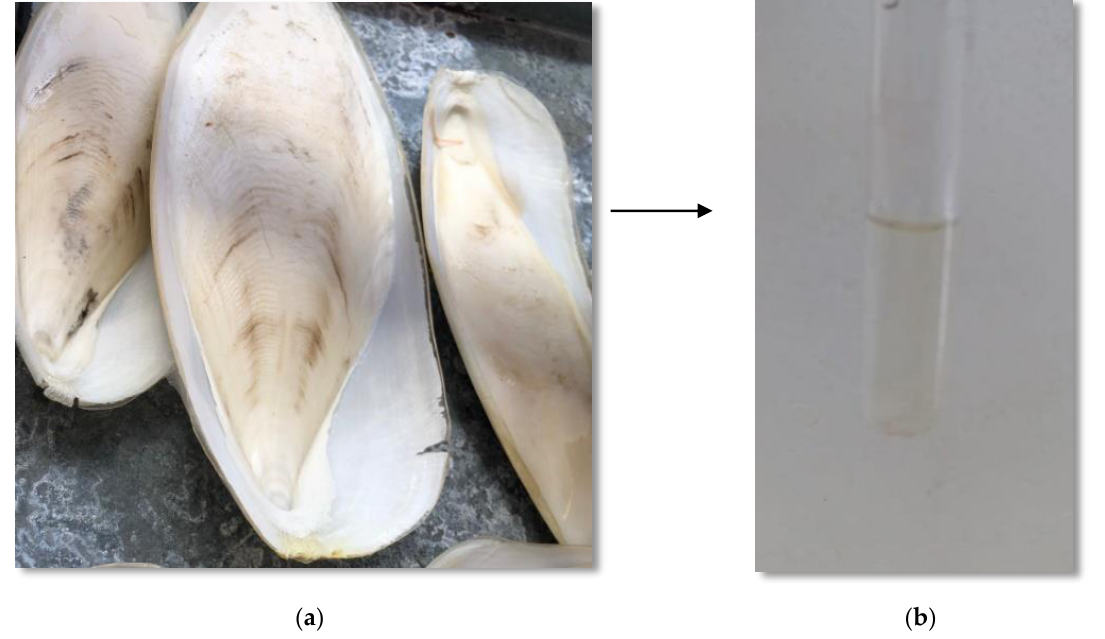
Figure 1. Transformation of cuttlefish bone into liquid extract after the deproteinization process: ( a ) Sepia officinalis bone and ( b ) Liquid extract from the deproteinization process .